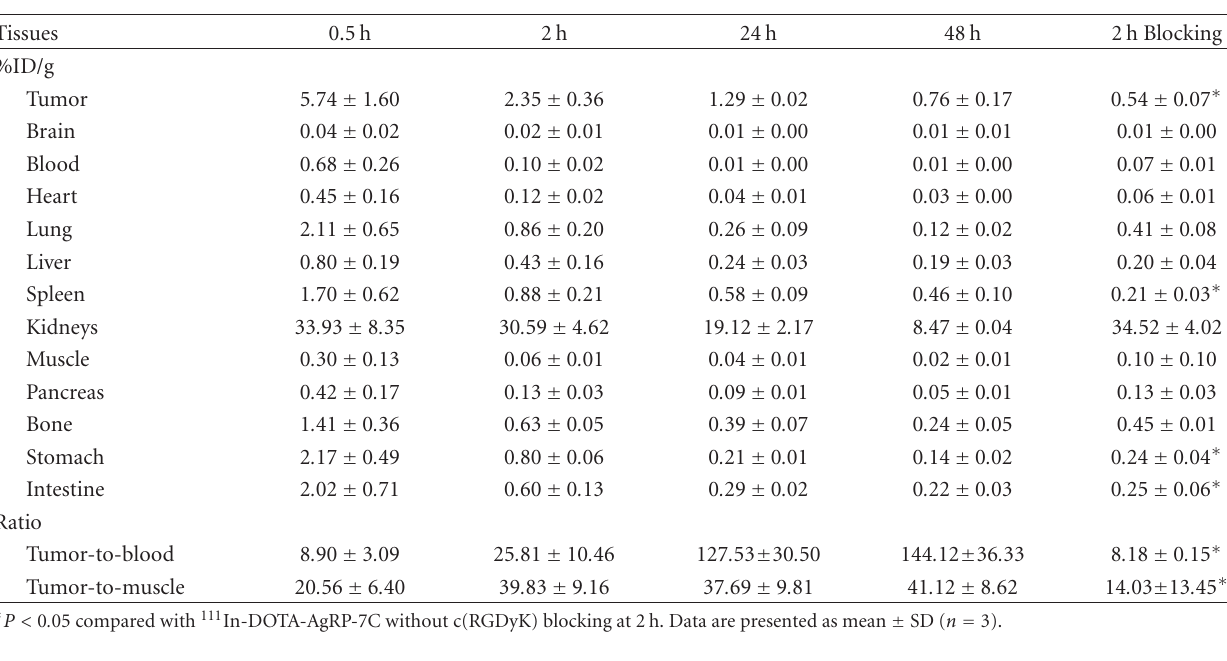
Table 2: Biodistribution results for 111 In-DOTA-AgRP-7C in nude mice bearing subcutaneous U87MG human glioblastoma xenografts. Data are expressed as the percent injected dose per gram of tissue (%ID/g) after intravenous injection of the probe (0.259–0.37 MBq, 7– 10 μ Ci) at 0.5, 2, 24, and 48 h ( n = 3). For 2h blocking group, mice were coinjected with 330 μ g of c(RGDyK).